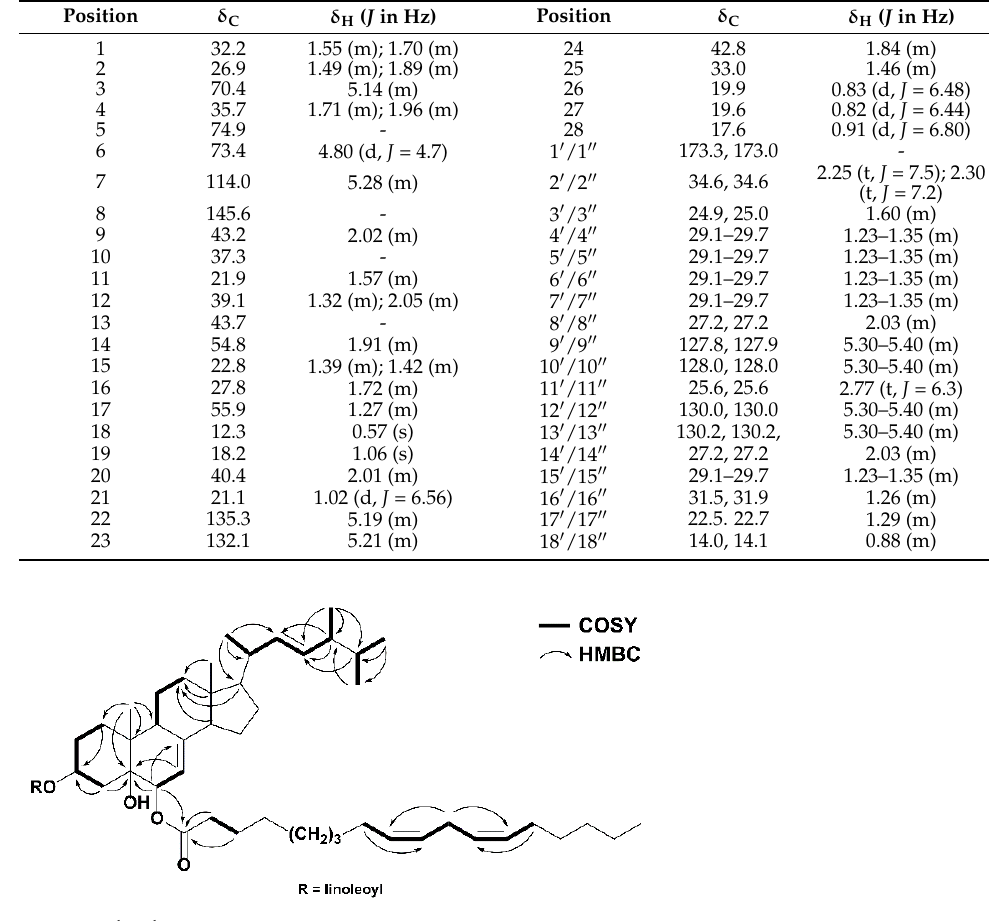
Figure 2. 1 H- 1 H COSY and key HMBC correlations of 1 . (COSY: correlation spectroscopy).